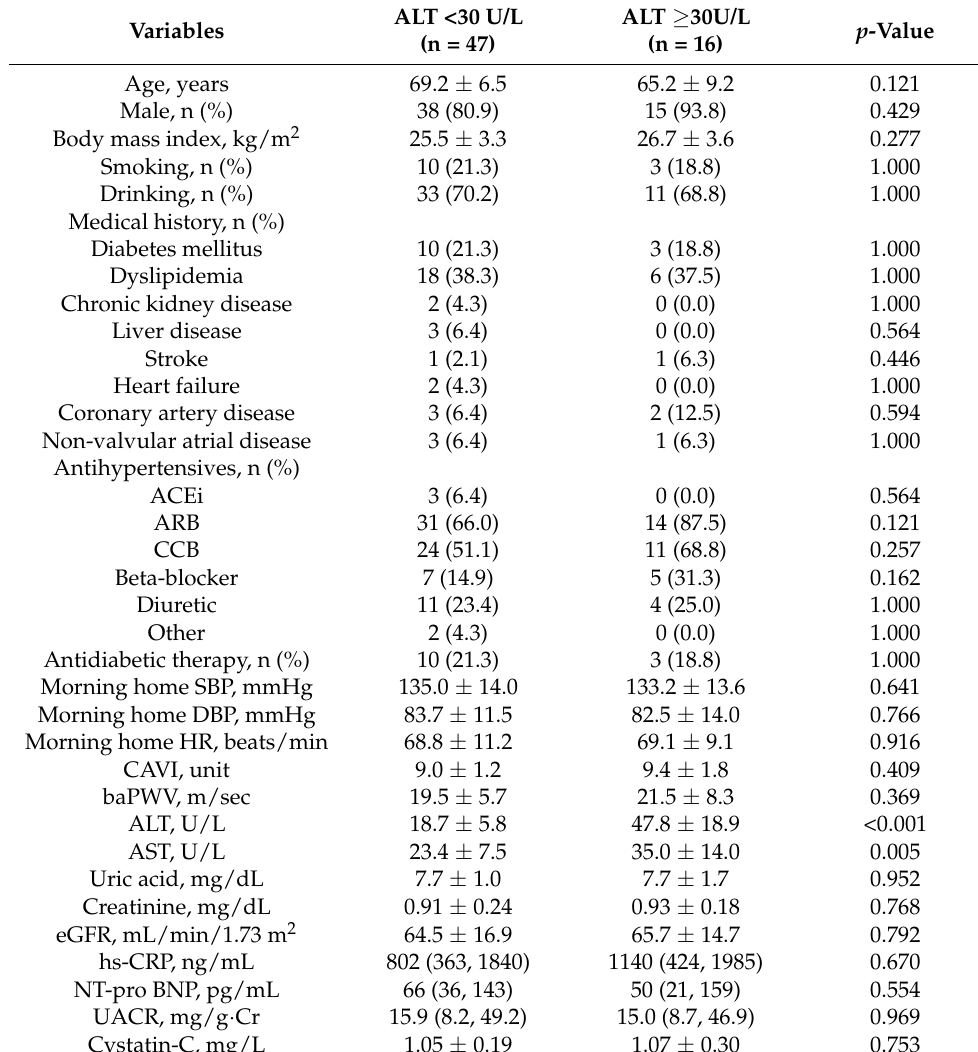
Table 2. Baseline clinical characteristics of participants with alanine aminotransferase level <30 U/L or ≥ 30 U/L.